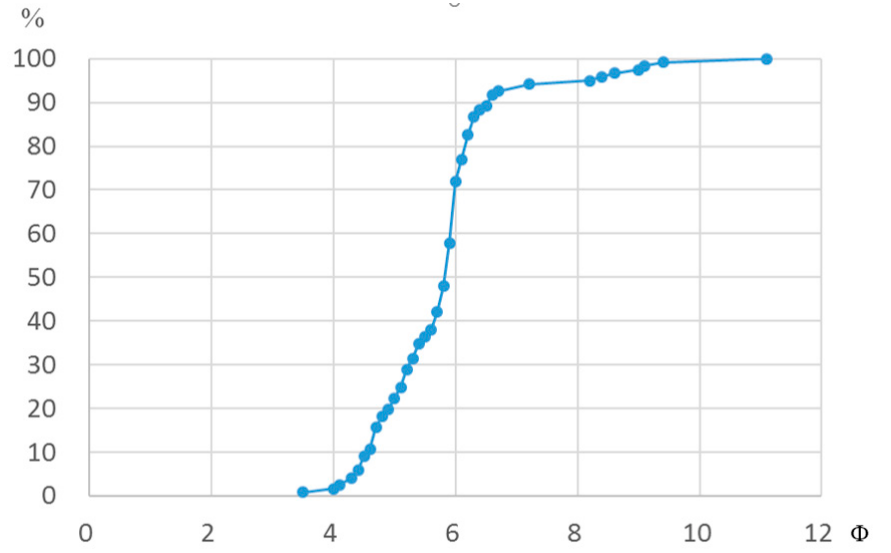
Figure 3. Granulometric curve of fine-grained sediments.